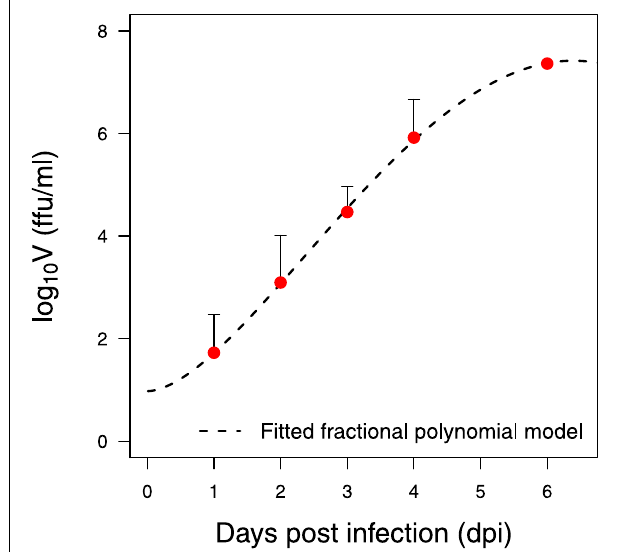
FIGURE 3 | Data preparation. Fitted statistical model for the wild-type Vero cells infected with EBOV at a low multiplicity of infection (MOI) (Halfmann et al., 2008